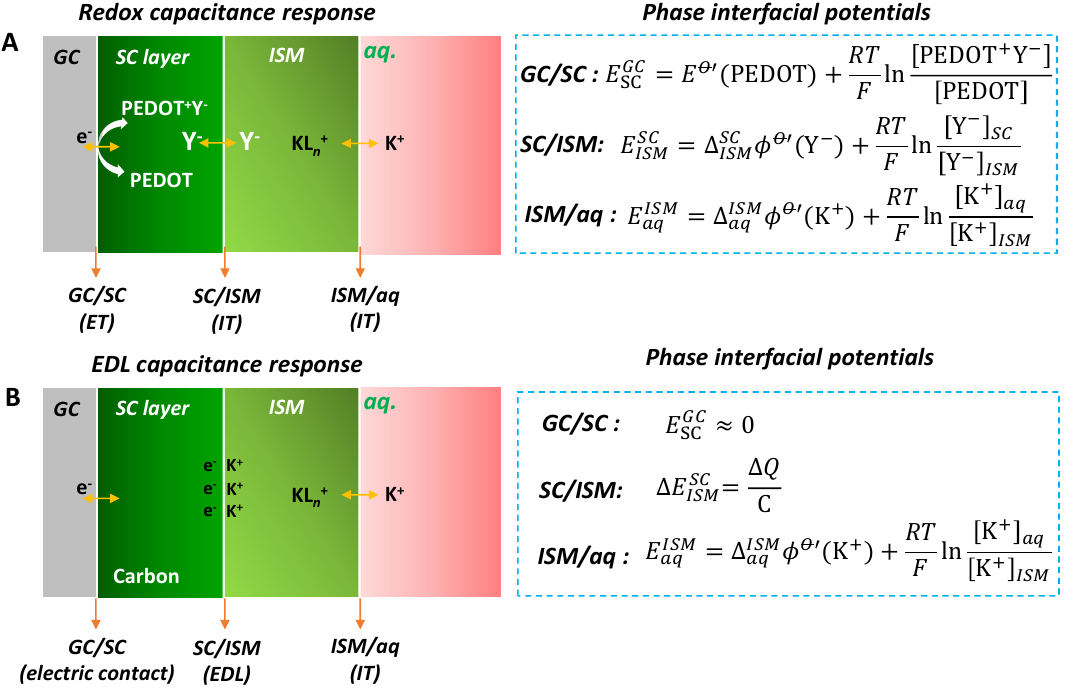
Figure 2. Response mechanisms for the SC-ISEs. ( A ) Redox capacitance-based SC-ISEs with poly(3,4-ethylenedioxythiophene) (PEDOT) as an example for redox SC transducer. ( B ) Electric-double-layer (EDL) capacitance-based SC-ISEs with carbon as an example for EDL SC transducer. Both SC-ISEs contain three interfaces, GC / SC, SC / ISM and ISM / aq. GC: glass carbon electrode substrate; SC: solid contact; aq: aqueous solution; ET: electron transfer; IT: ion transfer. The corresponding phase interfacial potentials are presented on the right (detailed illustration shown in the main text and Appendix).